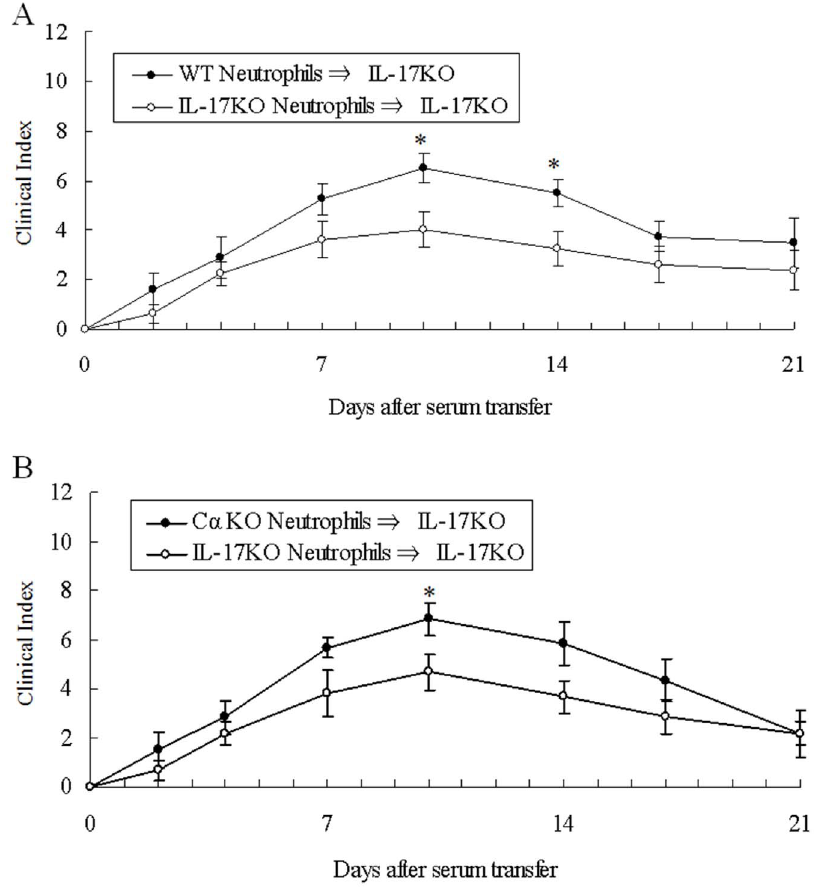
N Figure 4. IL-17 from neutrophils aggravates K/BxN serum-induced arthritis. (A) Neutrophils (2 6 10 6 /body) collected from bone marrow of ) mice were injected into IL-17 KO mice together with K/BxN sera (200 m l/body) at days 0 and 2. Clinical index of arthritis is IL-17 KO ( # ) or WT ( N shown. The results were from three independent experiments, both of which showed similar results. n=8 mice in each group. (B) Neutrophils ) mice were injected into IL-17 KO mice together with K/BxN sera (200 m l/ (2 6 10 6 /body) collected from bone marrow of IL-17 KO ( # ) or C a KO ( body) at days 0 and 2. Clinical index of arthritis is shown. n=6 mice in each group.*p , 0.05.